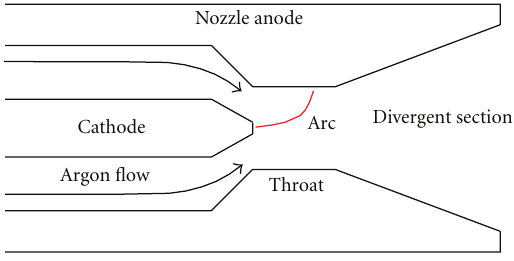
Figure 9: Schematic view of the